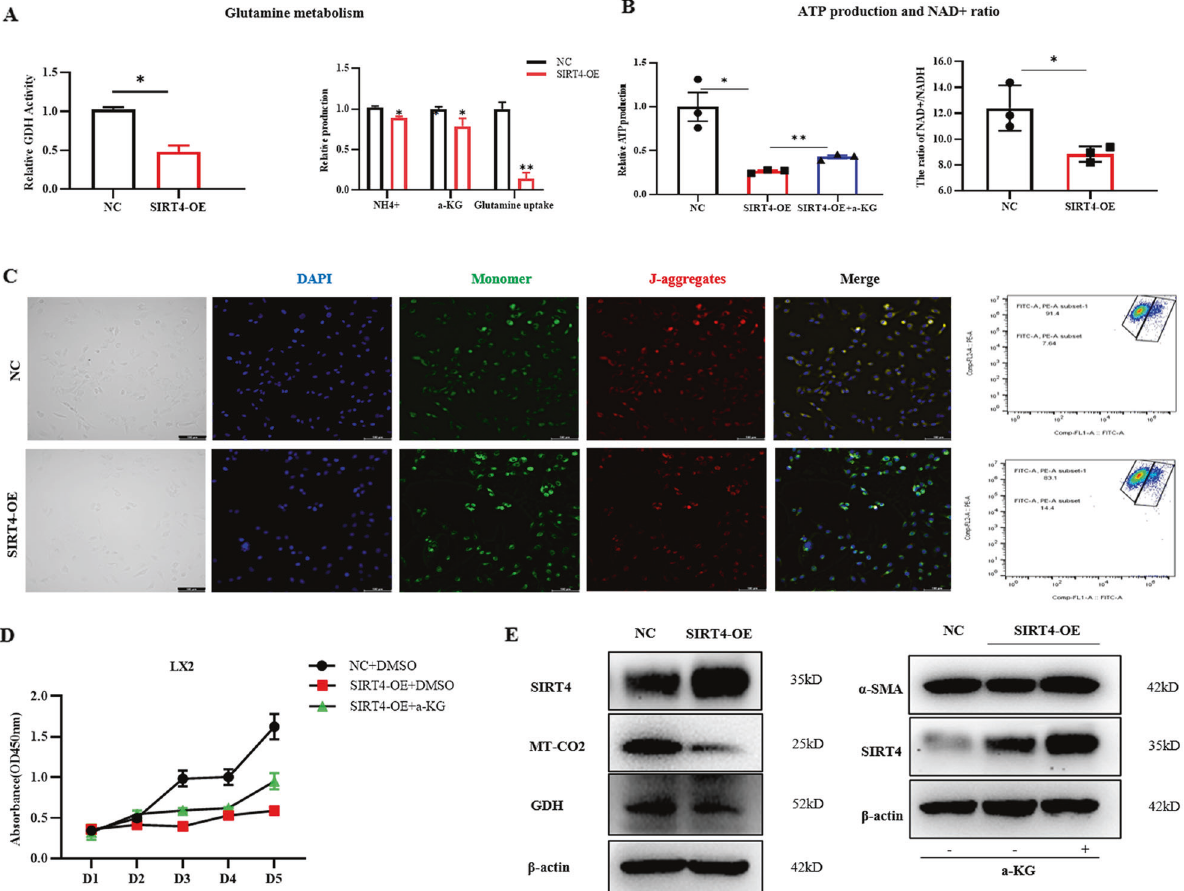
Fig. 6 SIRT4 alleviates HSCs activation by regulating glutamine metabolism. GDH activity and secreted a-KG and NH4 + levels were measured 48 h after SIRT4 overexpression plasmid transfection in LX-2 cells. B The ATP and NAD + levels decreased after SIRT4 overexpression. C The mitochondrial membrane potential decreased after SIRT4 overexpression, as shown by the JC-1 kit assay (scale bars = 100 μ m). Blue represents nuclei, green represents monomers, and red represents polymers. D Cell viability was determined by CCK-8 assay. E GDH and the mitochondrial marker MT-CO2 levels were signi fi cantly reduced after SIRT4 overexpression, as shown by Western blot analysis. The data are representative of the mean ± SD. * P < 0.05; ** P < 0.01; *** P < 0.001; **** P < 0.0001 versus the respective